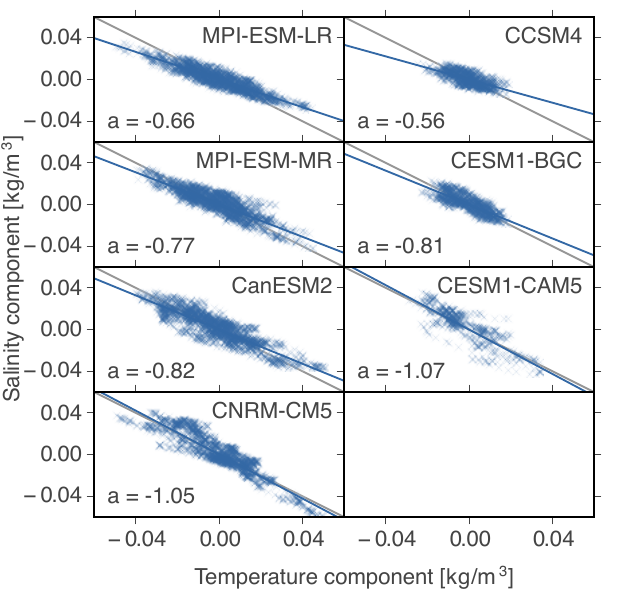
Fig. 10. Analytically derived power spectral densities for different model systems regressed on the individual model time series: green: fully coupled AMOC-NADO density system, blue: decoupled system c mρ = 0 , purple: AR(1) process, dashed red: a doubled AMOC–NADO coupling ( 2 × c mρ ,). AMOC spectra derived from the model time series rescaled relative to their maximum amplitude are shown in light grey.